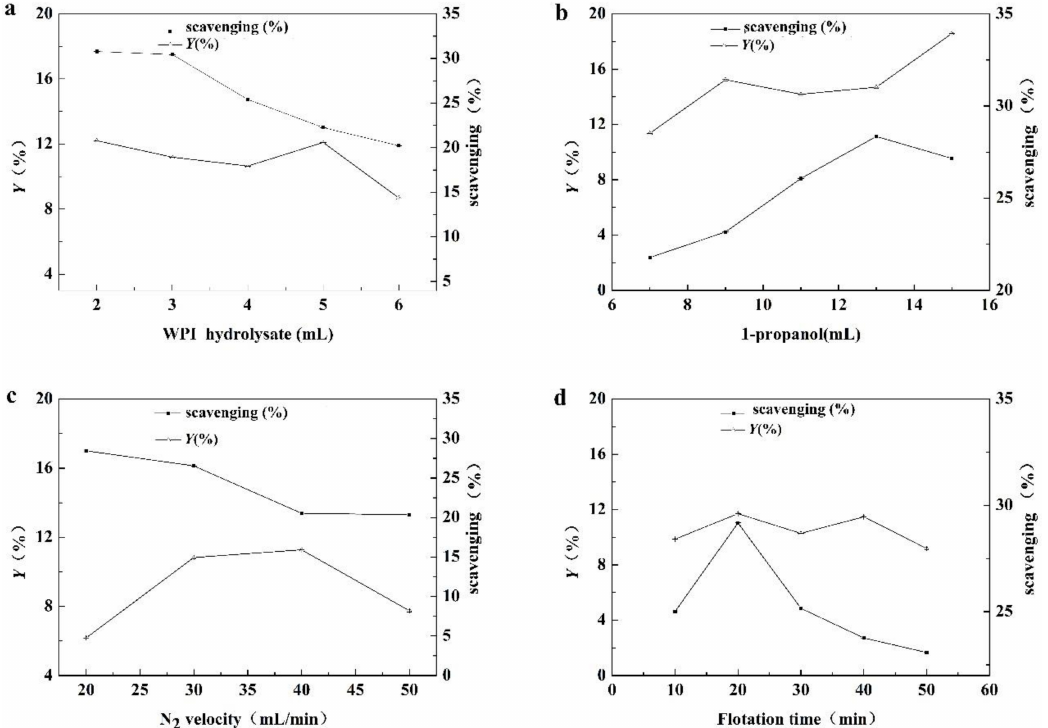
Figure 3. The effects of the volume of ( a ) WPI hydrolysate, ( b ) 1-propanol, ( c ) N 2 velocity and ( d ) flotation time on the separation of antioxidant peptides. The scavenging was ABTS free radical scavenging activity per unit concentration in top phase of aqueous two-phase flotation